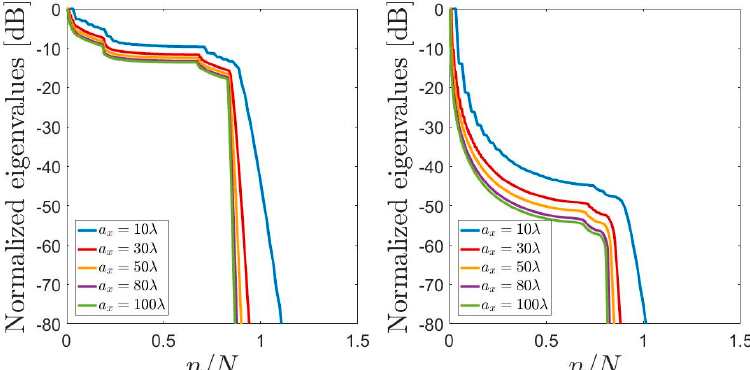
Figure 5. Normalized eigenvalues of the operators ℒ (cid:2968) (left panel) and ℒ (cid:2931) (right panel) for a semi- circumference source varying the radius.